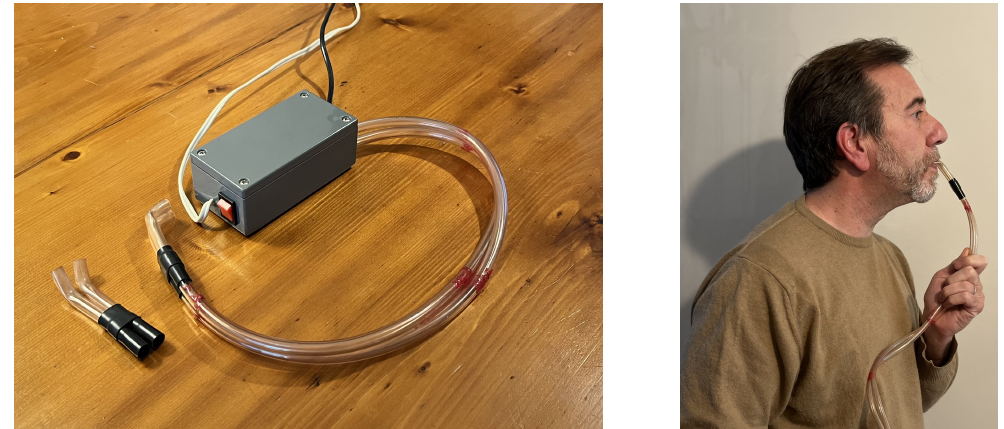
Figure 5. The interface designed for detecting postures of the oral cavity. It has a small loudspeaker, a microphone and two physical waveguides: one feeds white noise inside the mouth, and the other picks up the signal filtered by the oral cavity.